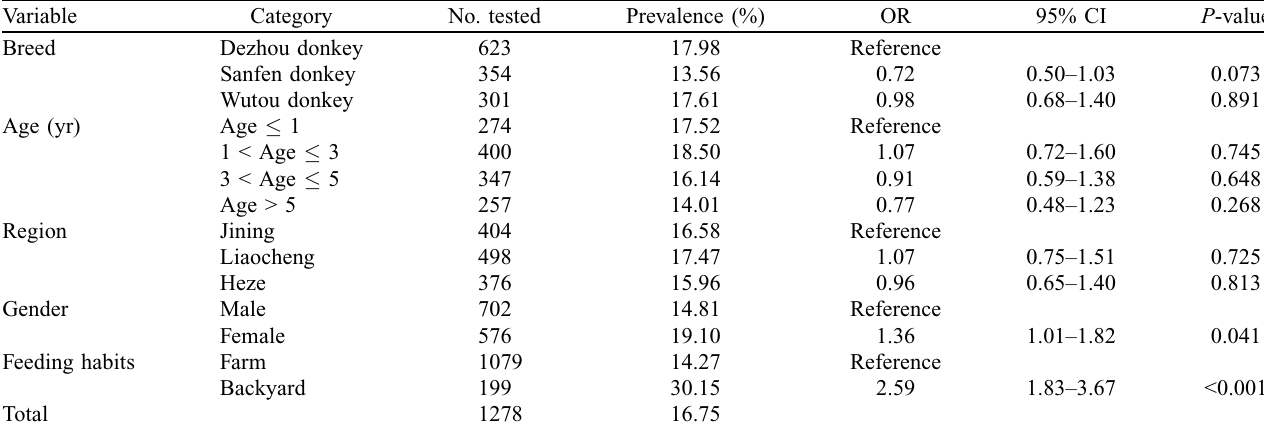
Table 2. Univariate analysis of the variables associated with T. gondii seroprevalence in donkeys in Shandong province, eastern China tested by IHA. Variable